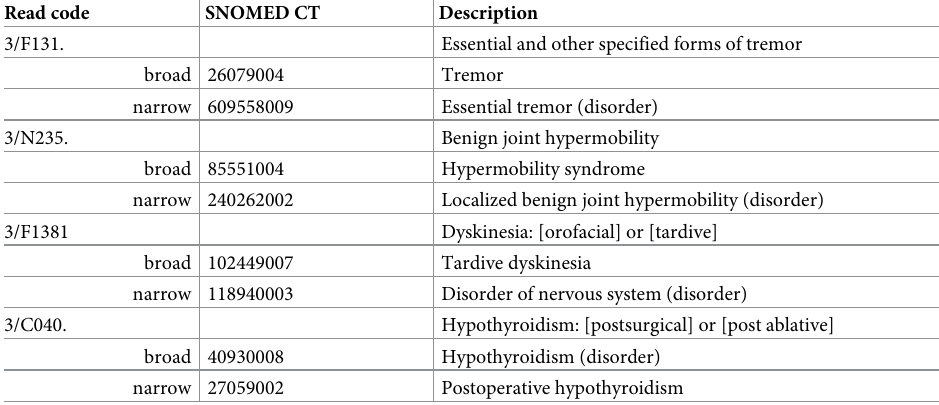
Table 4. Examples of broad and narrow mapping between Read codes and SNOMED CT